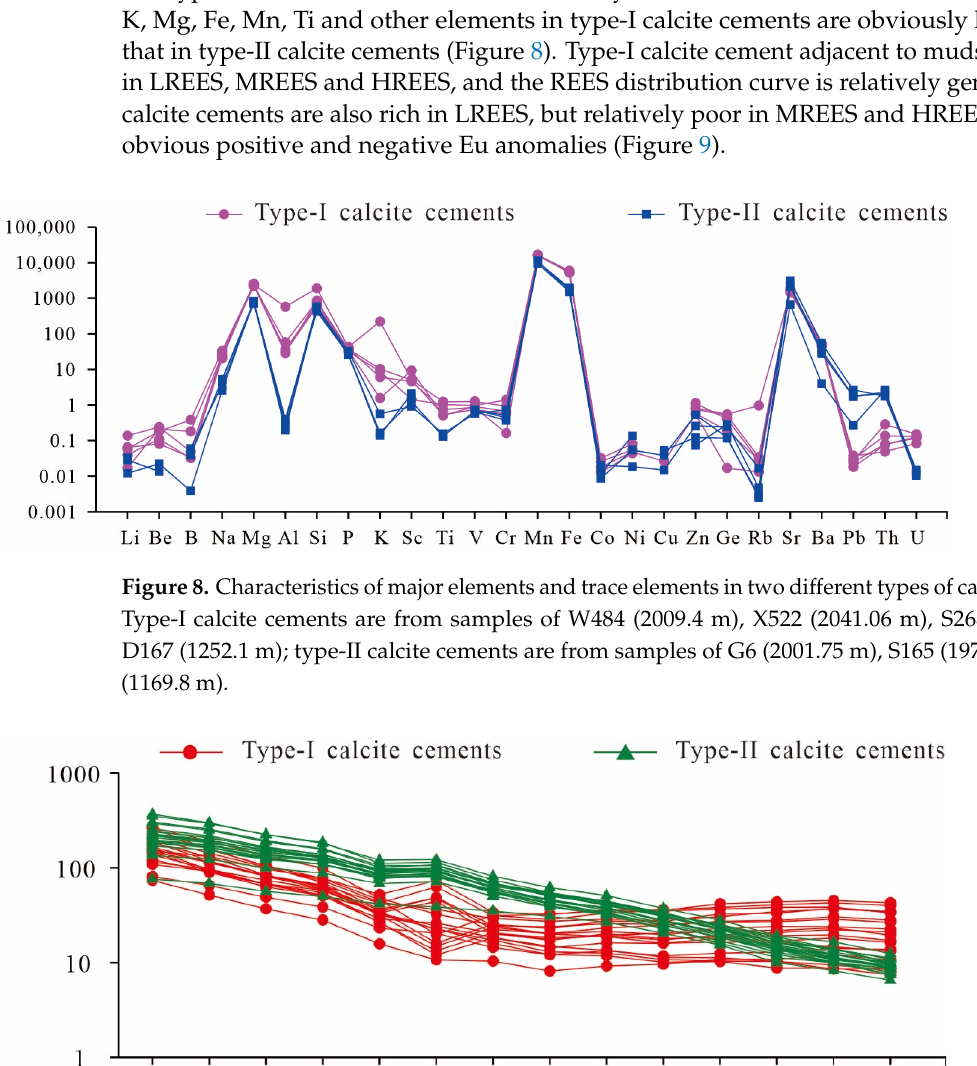
Figure 7. Correlation between calcite cement content and the distance to mudstone.